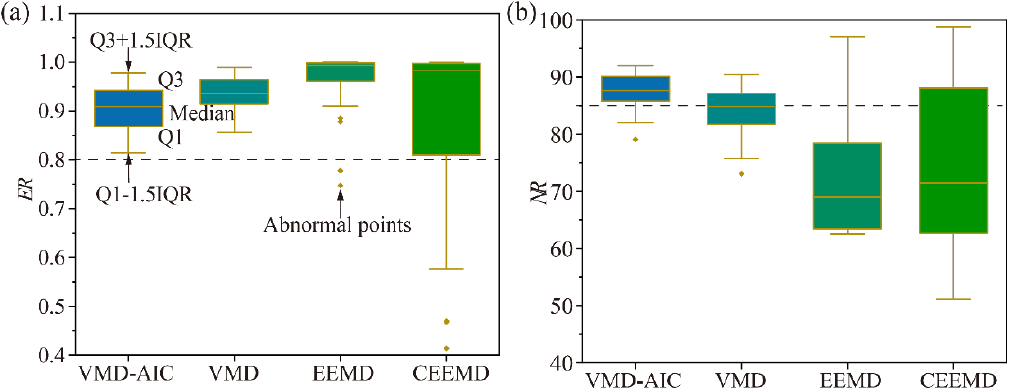
Figure 11. The box diagrams of noise ratio ( NR ) and energy ratio ( ER ) of 40 noisy field signals obtained by VMD-AIC, VMD, EEMD, CEEMD. ( a ) NR ; ( b ) ER . Q1 is the lower quartile point of the data set, and Q3 is the upper quartile point. IQR is the quarter-point spacing, whose value is equal to Q3-Q1. The points outside the limits of the box are considered abnormal points [39] .